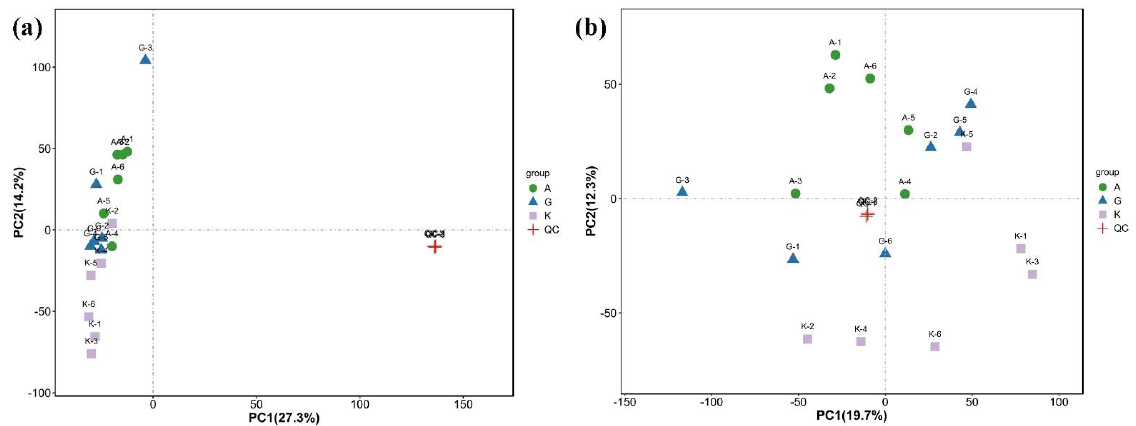
Figure 2. Quality control. ( a ) PCA diagram of POS ions. ( b ) PCA diagram of NEG ions.